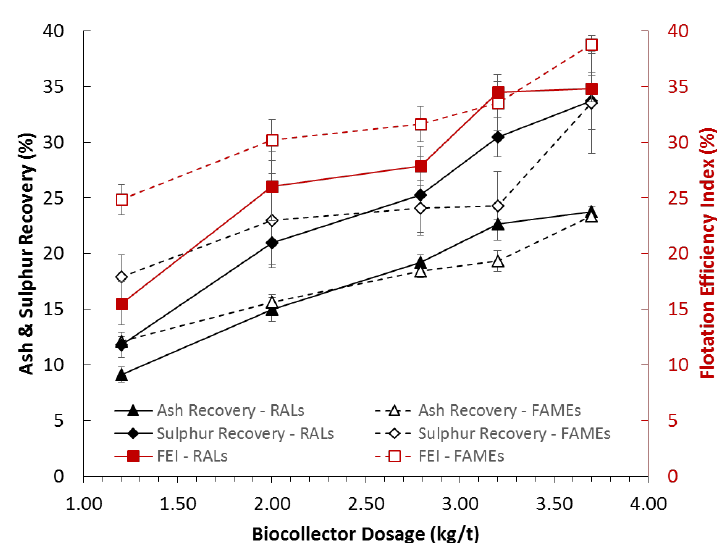
Figure 3. Ash recovery, sulphur recovery and FEI for Site 1 flotation experiments as a function of RAL and FAME dosage at pH 2.7.